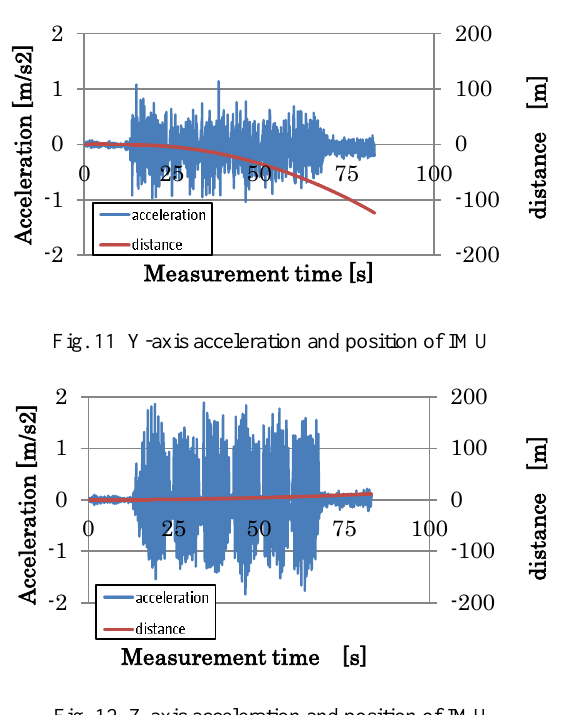
Fig. 12 Z-axis acceleration and position of IMU As the camera that was actually used is not synchronized with the IMU through a hardware-based synchronizer, the camera must be synchronized with the IMU in another way. We angular velocity. As shown in Equation (2), the acceleration on the plane is calculated from the X-axis acceleration and Y-axis acceleration.